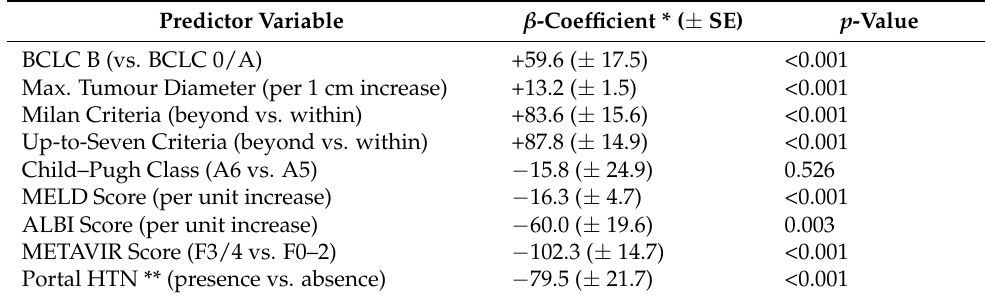
Table 2. Prediction of platelet count by simple linear regression.